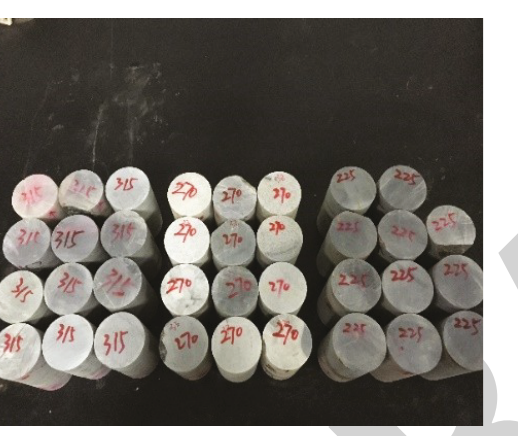
Figure 6: Coring on the site.